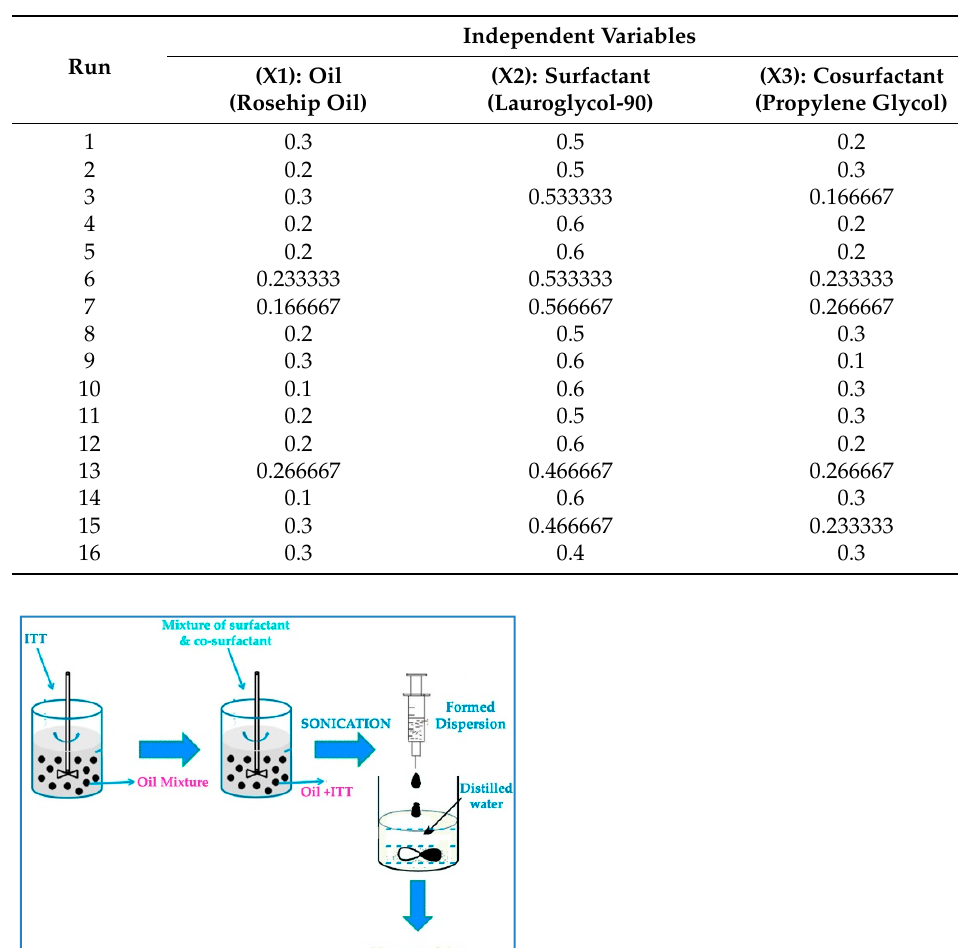
Table 3. Mixture design for the development of ITT-QRS-loaded self-nanoemulsifying drug delivery system (SNEDDS).